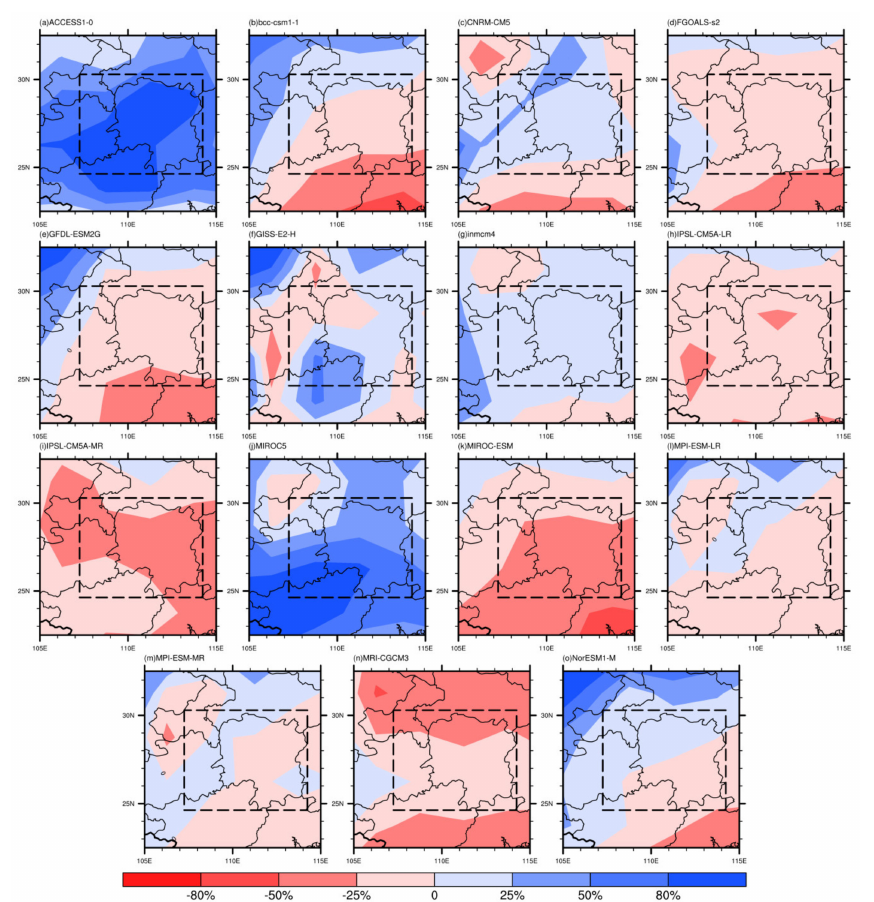
Figure 3. The percentage of the precipitation anomalies of 15 models in the flood season from 2006 to